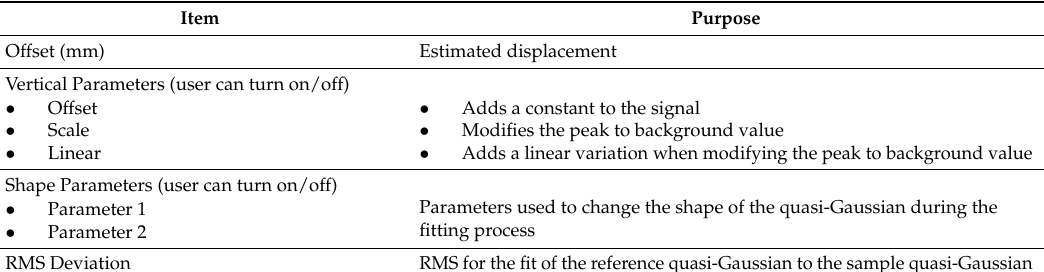
Table 2. Options for fit of reference signal to displaced signal.